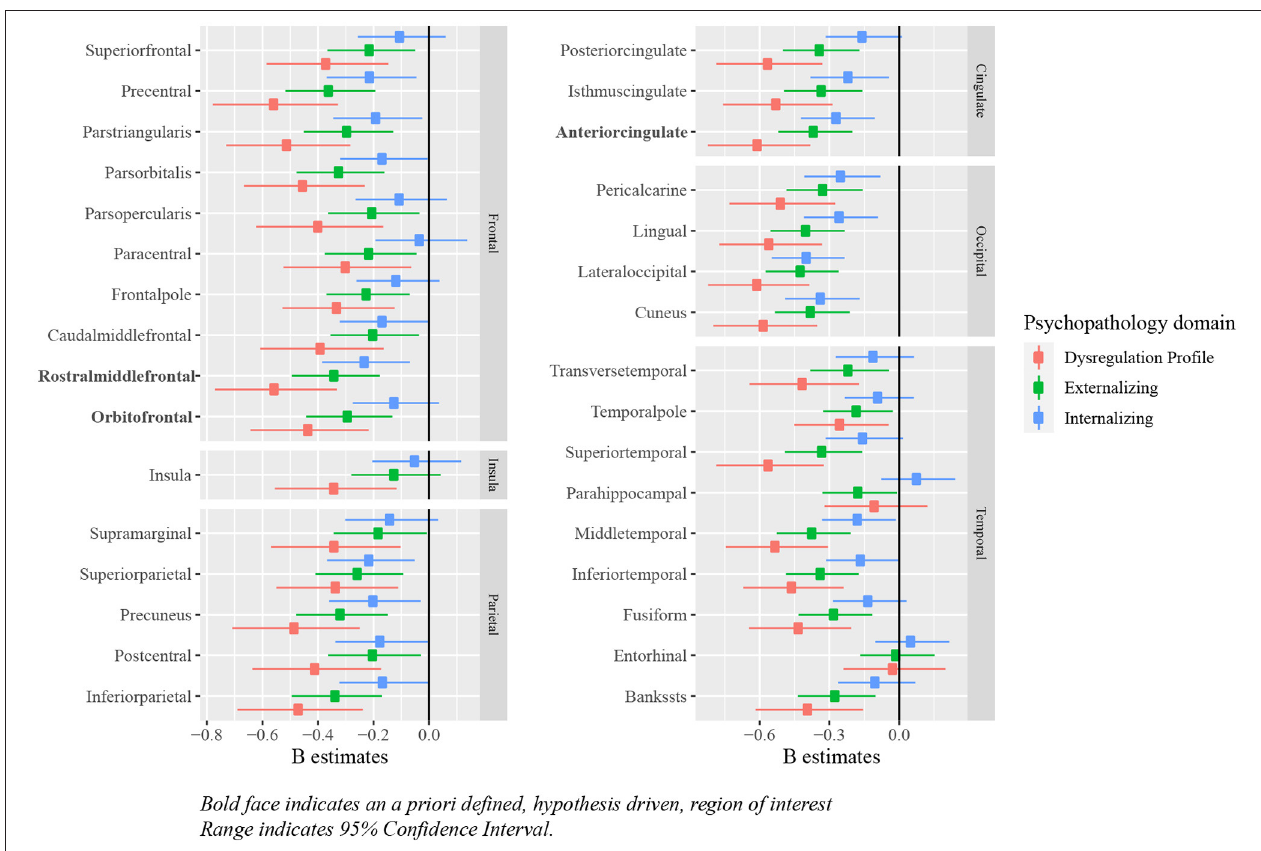
FIGURE 8 | Standardized B estimates of the relationship between z-scores (representing deviations of typical development in surface area) and psychopathology symptoms. Bold face indicates an a priori defined, hypothesis driven, region of interest range indicates 95% confidence interval.